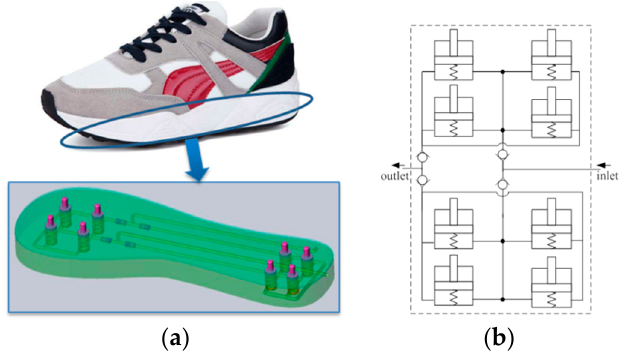
Figure 13. Micro insole embedded hydraulic energy harvester; ( a ) insole regeneration mechanism; ( b ) hydraulic circuit.